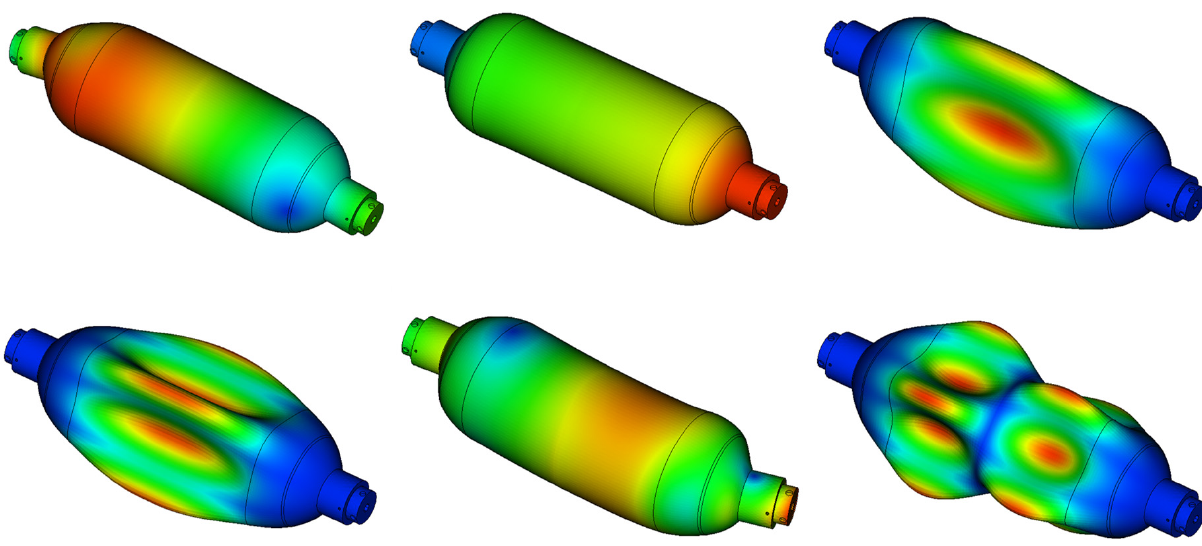
Figure 3. Indicative eigenmodes of the FE model in the range of 0 to 1500 Hz.